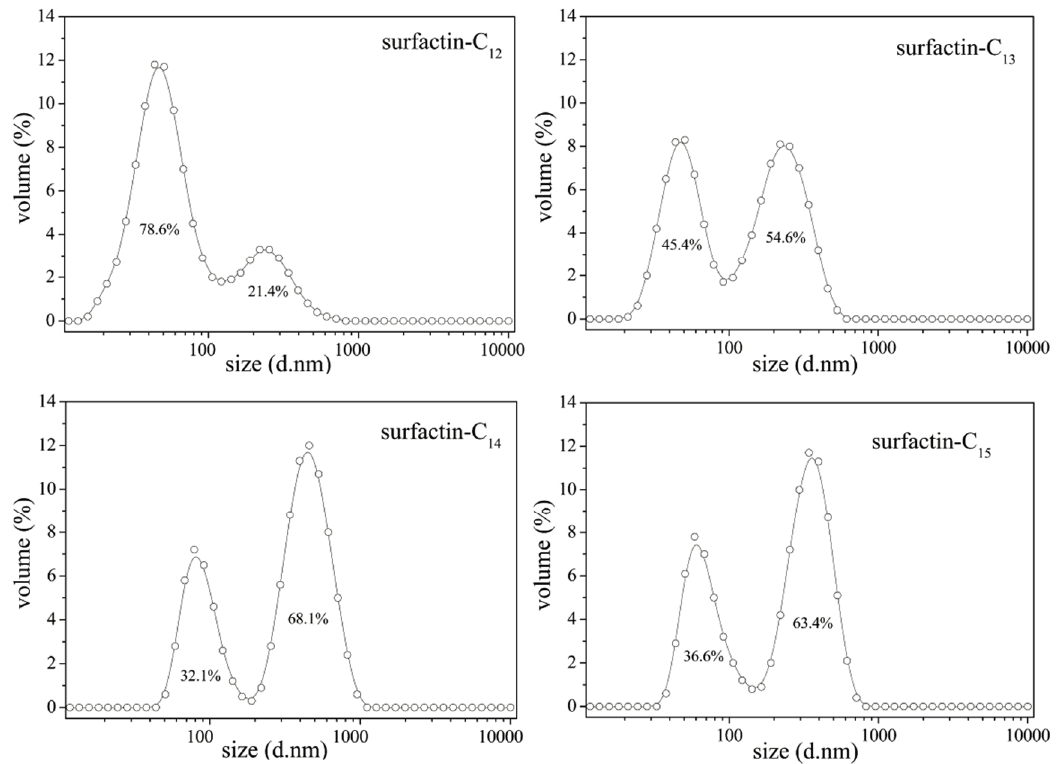
Figure 8. Micelle size distribution of surfactin-C13, -C14 and -C15